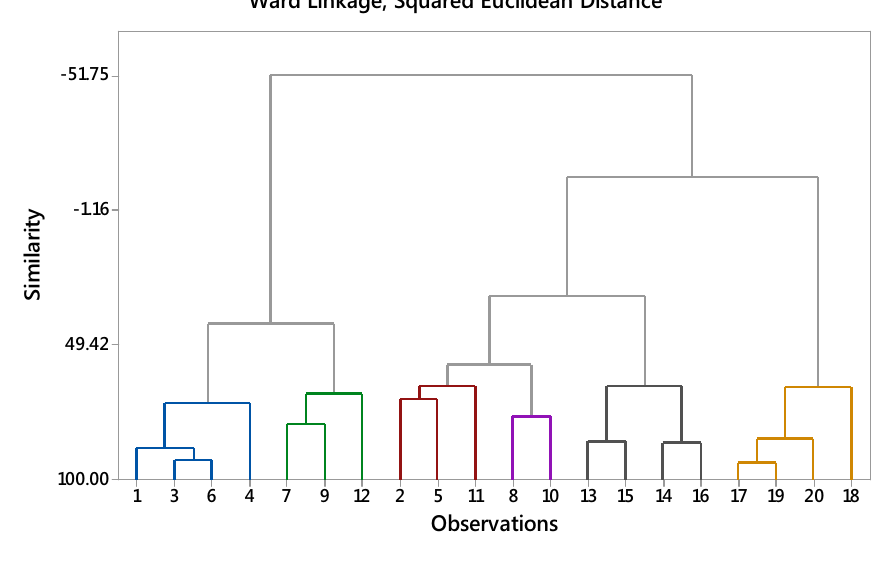
Fig. 3 Dendrogram of various sampling